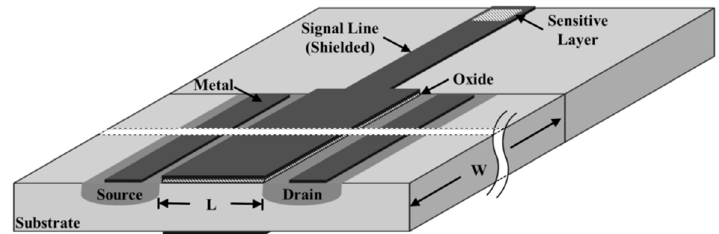
Figure 1. Schematic of a monolithic extended-gate field-effect transistor in which the sensitive interface is placed far from the metal–oxide semiconductor field-effect transistor (MOSFET).